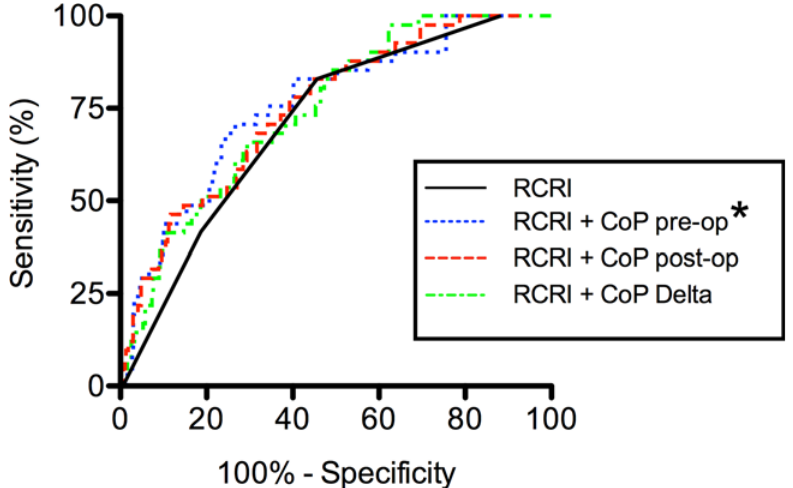
Fig 2. ROC analysis comparing the RCRI alone or combined with Copeptin-derived parameters. Only preoperative Copeptin (blue dotted line) improved risk predictive accuracy of the RCRI (P = .0371, AUC .752). The RCRI-ROC Curve (black line) (AUC .714) indicates prediction of the occurrence of major adverse cardiovascular events (MACE). The combination of RCRI and postoperative Copeptin (red dashed line) (P = .0620, AUC .751) and RCRI and Copeptin changes (P = .1525, AUC .710) during the perioperative course (green dashed and dotted line) do not reach significantly larger AUCs. * marks significant